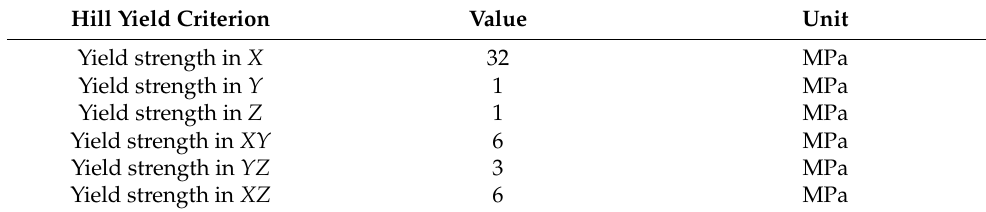
Table 4. Values for the plastic behavior of the material model for timber; Johanides 2022